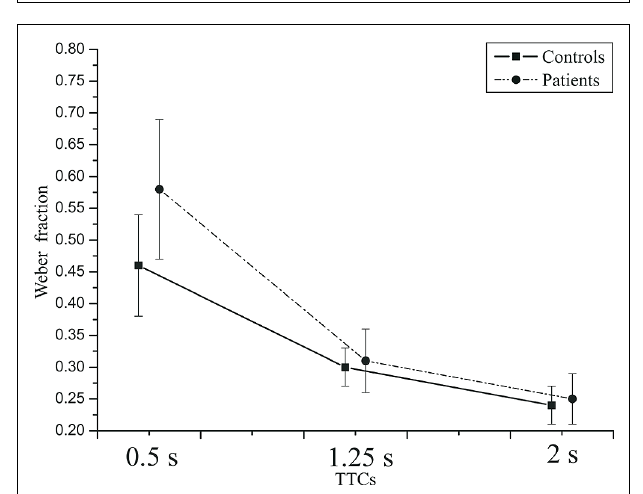
FIGURE 8 | MeanWeber fractions as a function ofTTC in controls (squares) and patients (circles). Error bars: 95% CIs.